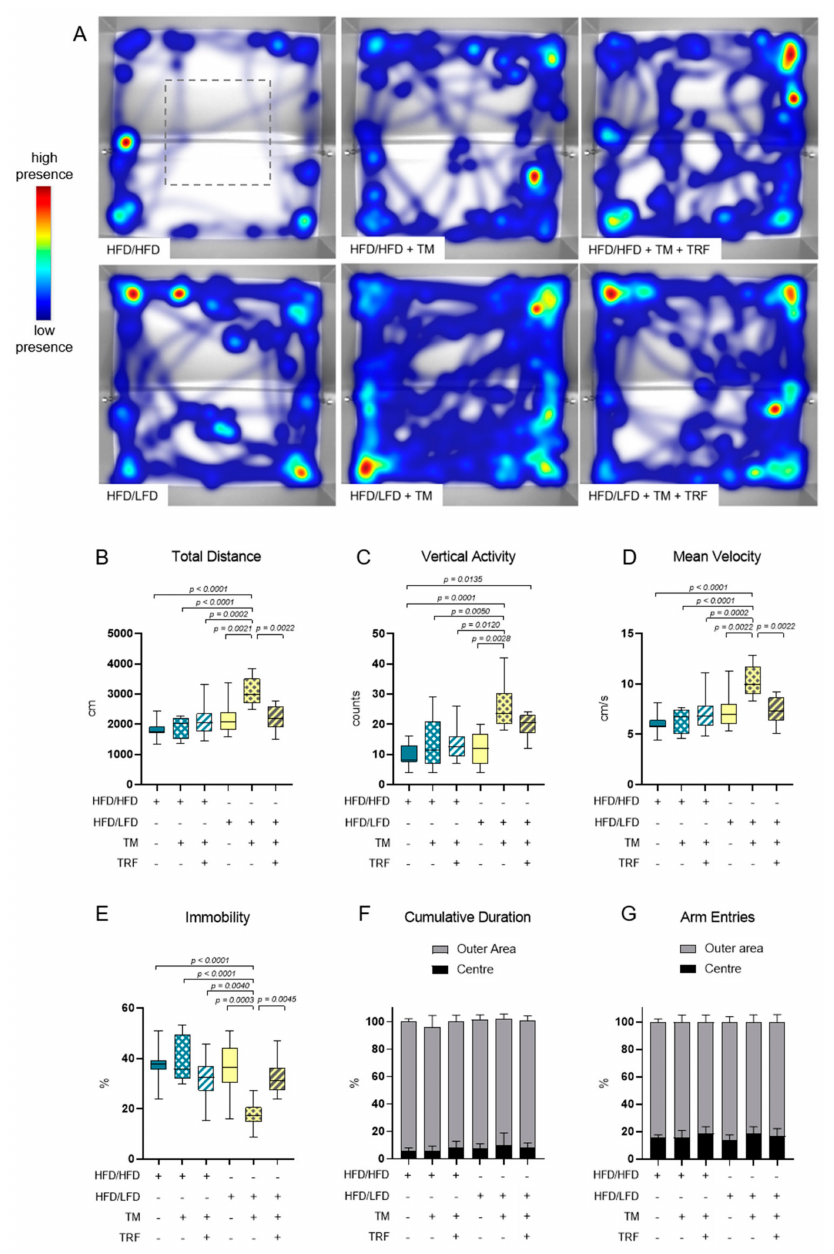
Figure 6. Open Field (OF) analysis. The combination of a diet change and treadmill exercise leads to more locomotor activity. ( A ) Heatmap presentation of animal presence in maze over 300 s whereas red colour reveals highest residence and blue colour lowest duration. The number of mice that exhibited the shown pattern amounted to: HFD/HFD: n = 5/9, HFD/HFD + TM: n = 3/8, HFD/HFD + TM + TRF: n = 5/10, HFD/LFD: n = 3/8, HFD/LFD + TM: n = 5/10, HFD/LFD + TM + TRF: n = 4/9; total n = 54. Grey dashed line indicates the centre. Boxplots indicate ( B ) total distance [cm] moved over 300 s, ( C ) vertical activity [counts] by manual counting of rearing, leanings and jumps, ( D ) mean velocity [cm/s] calculated from distance moved in maze over 300 s and ( E ) immobility pattern represented in [%]. ( F , G ) Column bars show cumulative duration [%] and arm entries [%] in the outer area (light grey) and the centre (black), respectively. Significance of differences were tested by Kruskal–Wallis with Dunn’s post hoc test for multiple comparisons (F) or by ordinary one-way ANOVA with Tukey post hoc test for multiple comparisons (B: F = 9.756, DF = 5; C: F = 7056, DF = 5; D: F = 9.710, DF = 5; E: F = 8.886, DF = 5; G: F = 1.420, DF = 5). Data are presented as mean ± SD and statistical significance was set at p < 0.05. Abbreviations: HFD: high-fat diet, LFD: low-fat diet, TM: treadmill, TRF: time-restricted